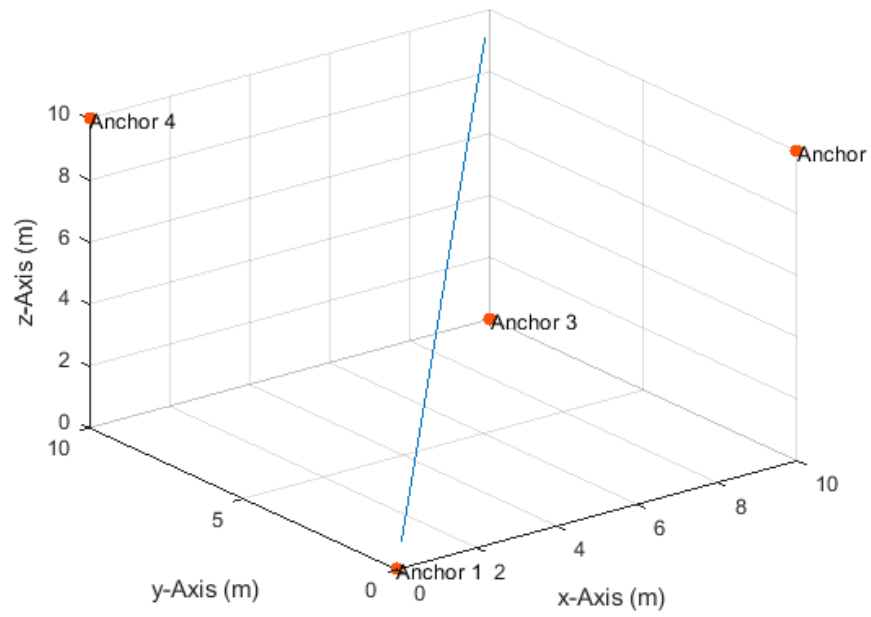
Figure 1. Anchor node arrangement and the three-dimensional (3D) linear path.